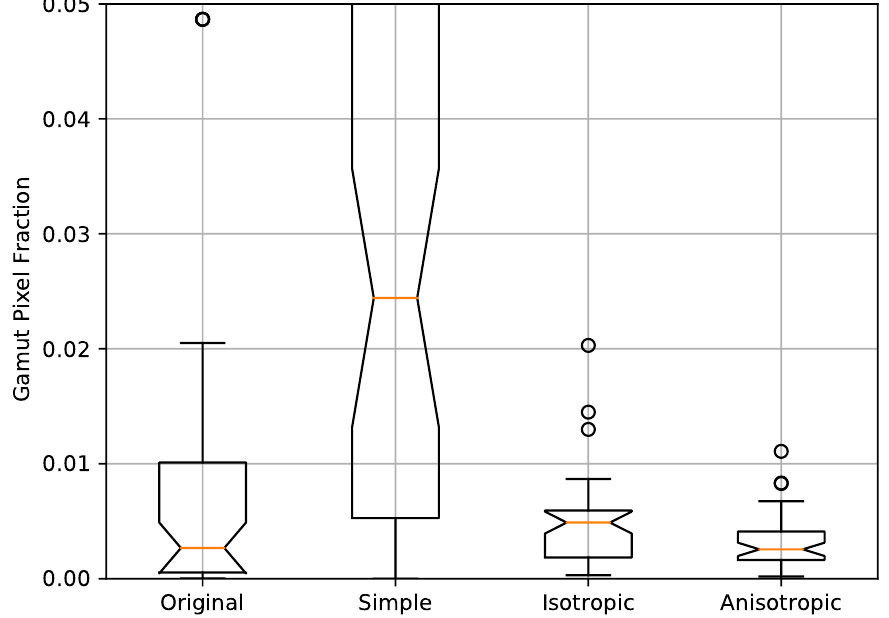
Figure 4. Box plot of the gamut pixel fraction ( GPF ) for the original and the simple, isotropic, and anisotropic daltonised